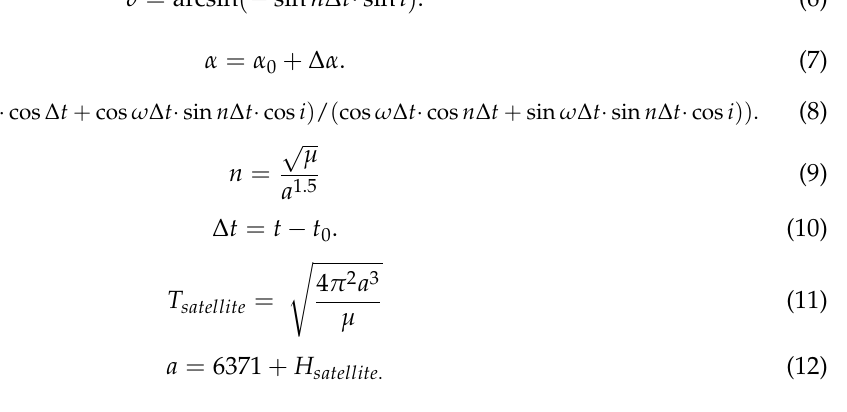
Table 2. Parameters for the orbit sampling